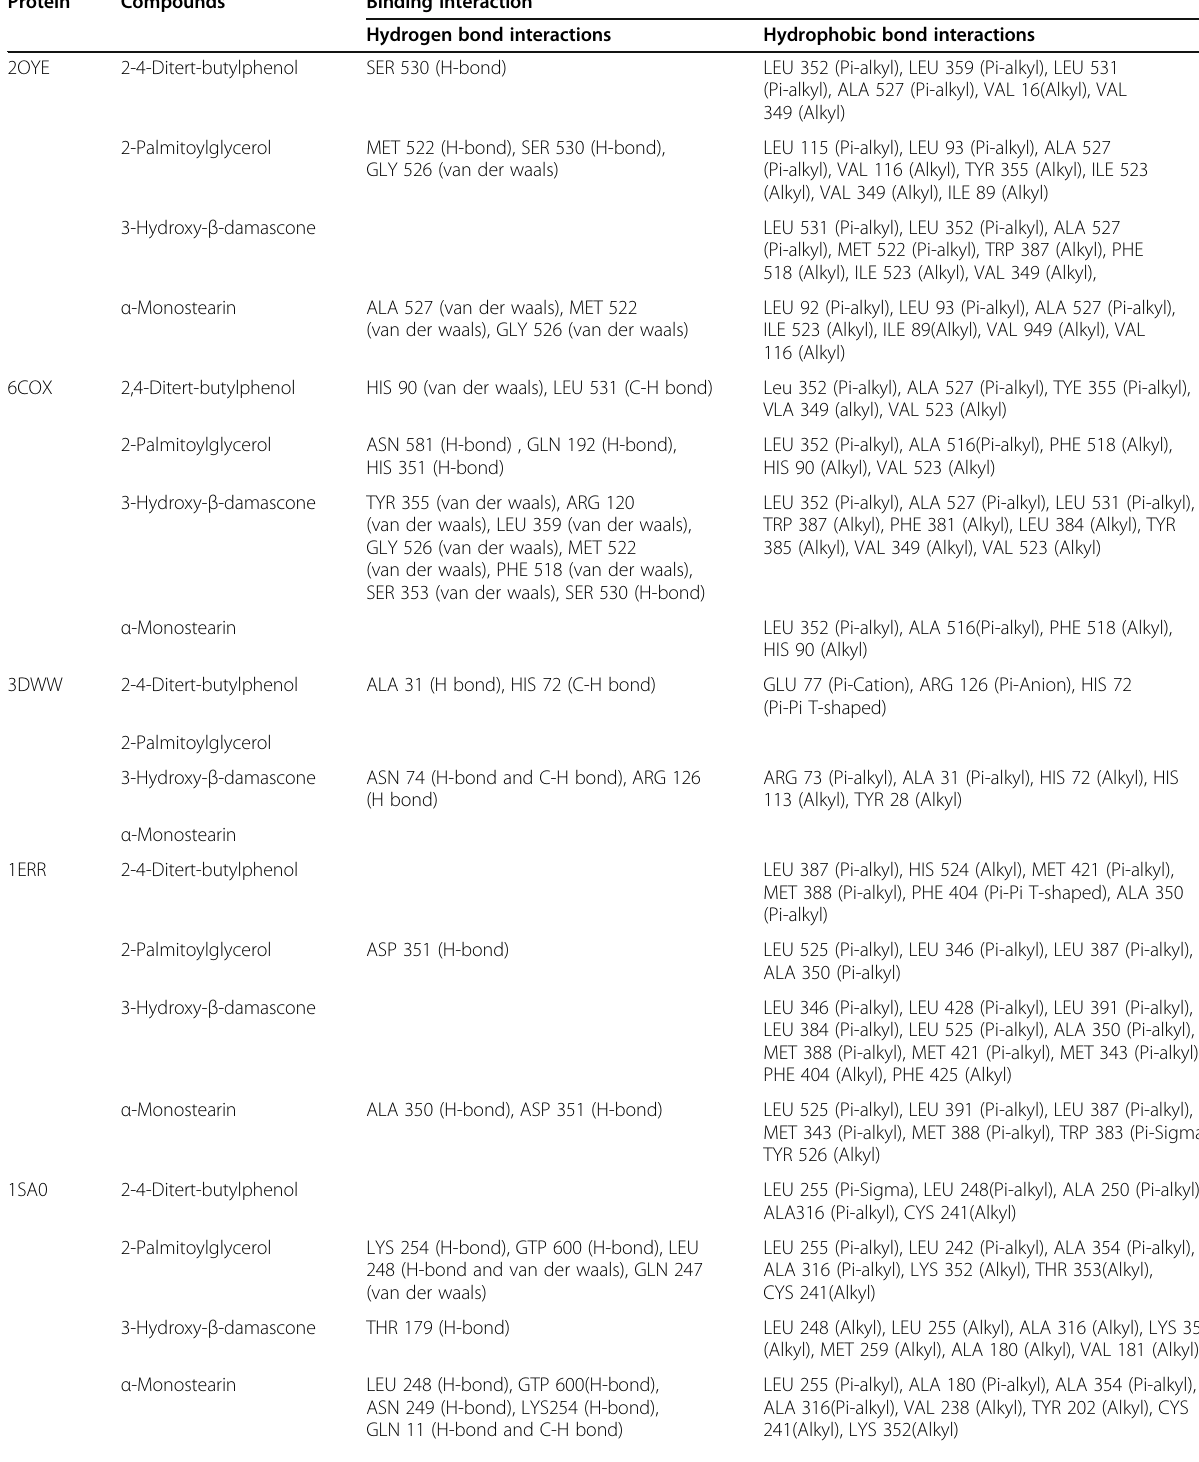
Table 4 Binding interactions of isolated compounds with the respective proteins for different biological activities